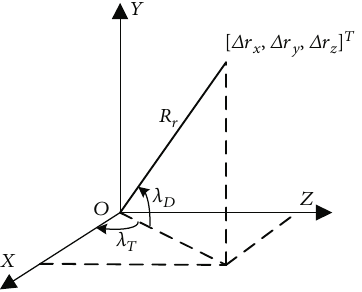
Figure 2: Schematic diagram of a radar measurement of the target